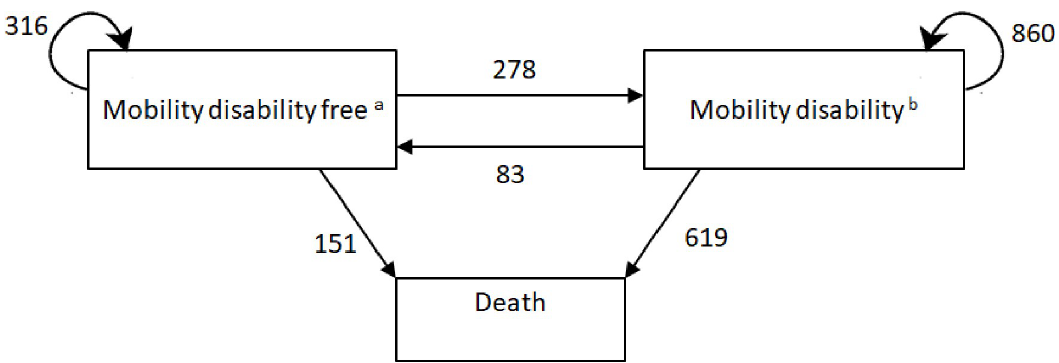
Fig 1. Markov multistate transition model for mobility disability-death in the Newcastle 85+ Study. a Censored = 23; b Censored = 53. Note: numbers represent the number of transitions between states, not the number of people that moved. For example, there were 83 transitions, classed as recovery, from the mobility disability to mobility disability-free state, while there were 316 transitions for remaining mobility disability free between the Newcastle 85+ Study waves and 860 transitions for remaining with mobility disability between the study waves.